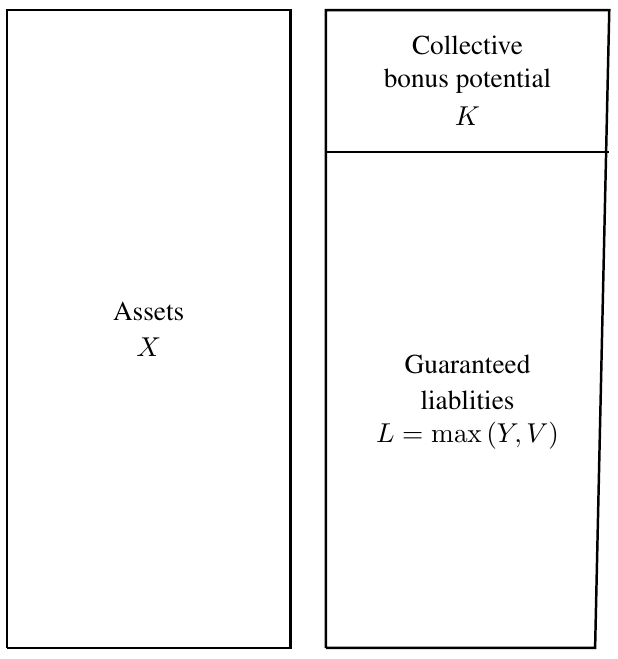
Figure 1. Portfolio balance